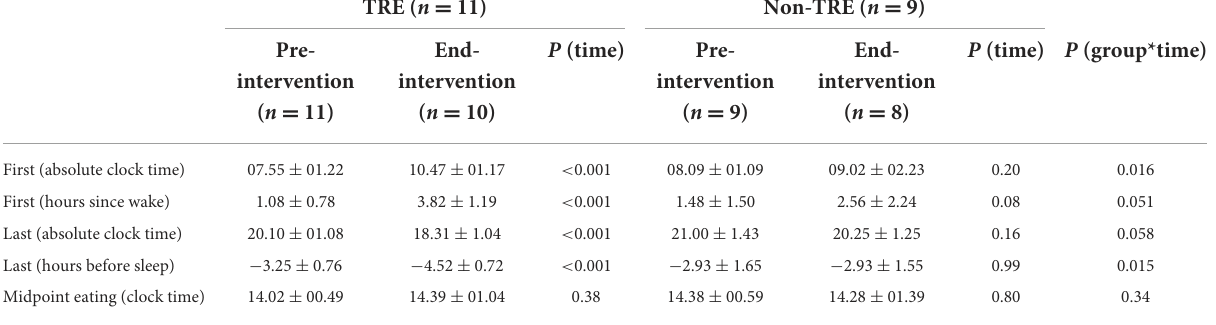
occasions in the non-TRE group remained similar between pre- to